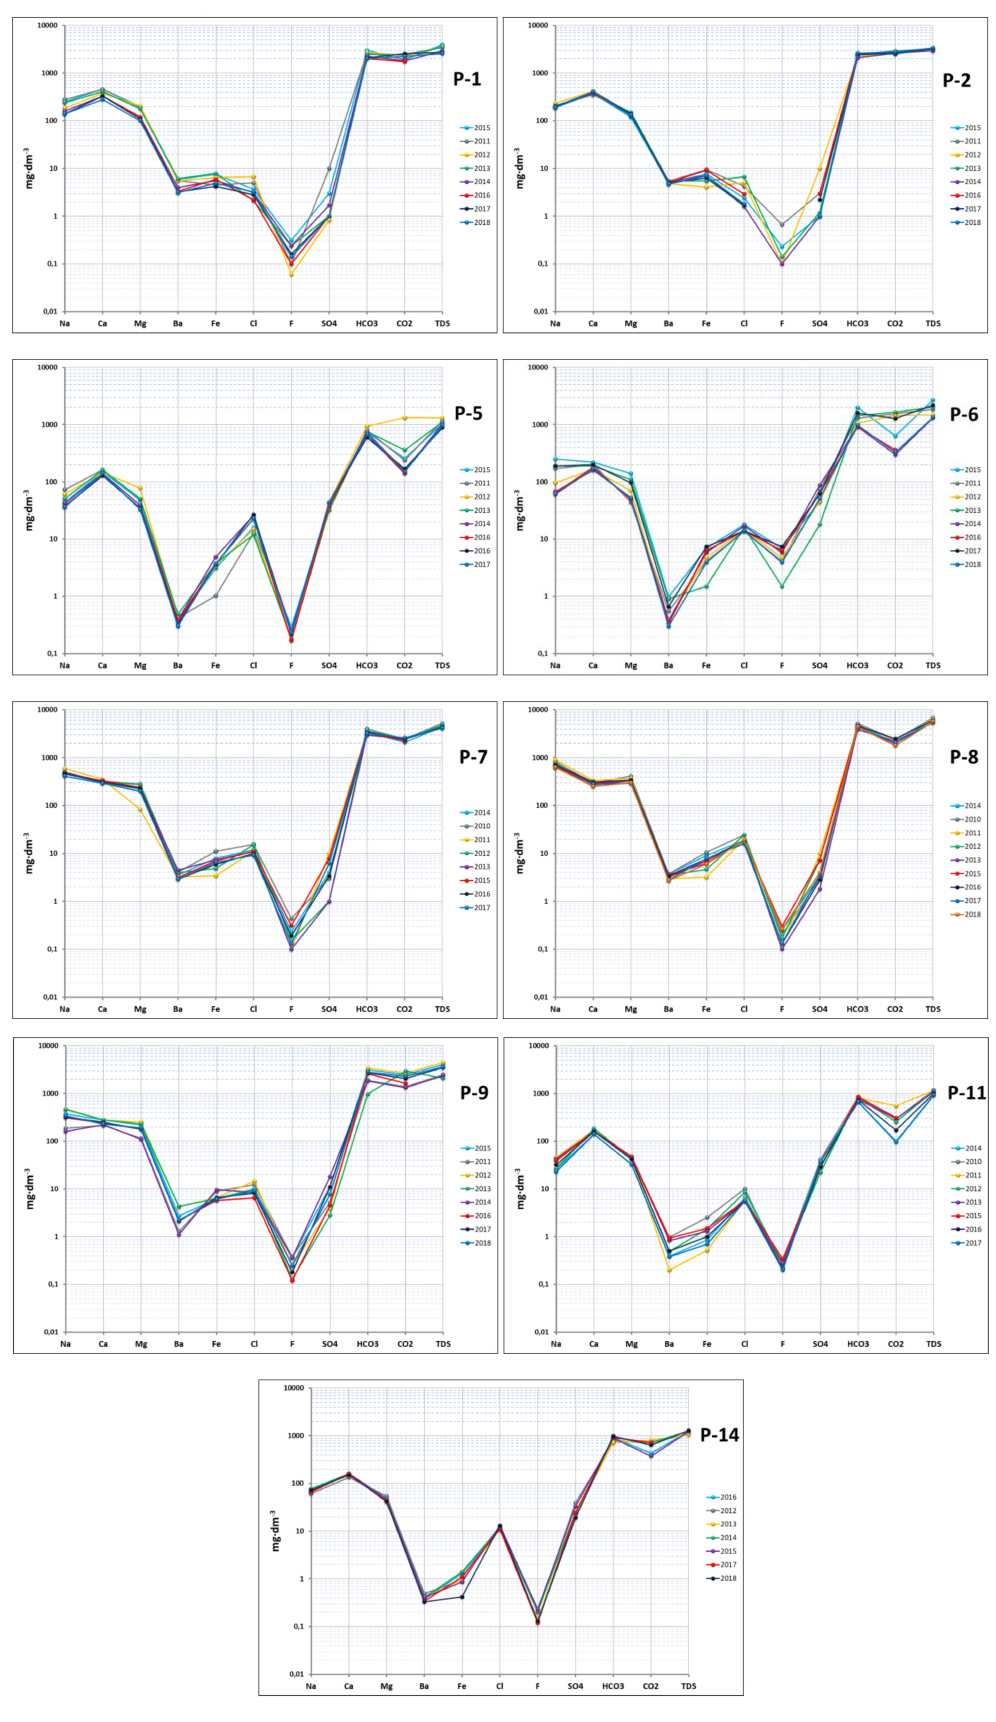
Figure 4. Schoeller–Berkalo ff plots of analyzed